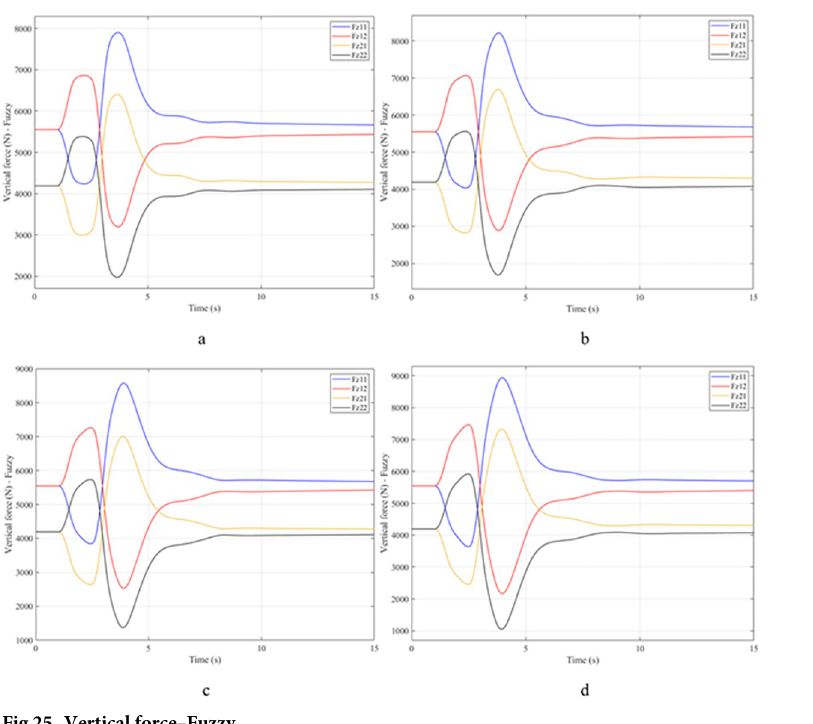
Fig 25. Vertical